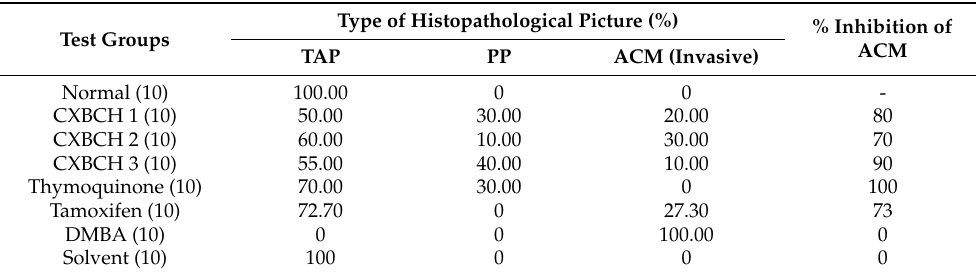
Table 5. Histopathological examination of mammary tissue with or without mammary tissue tumor nodules in SD rats induced with DMBA and receiving CXBCH treatment two weeks before and five weeks during induction. Tissue collection was carried out at week